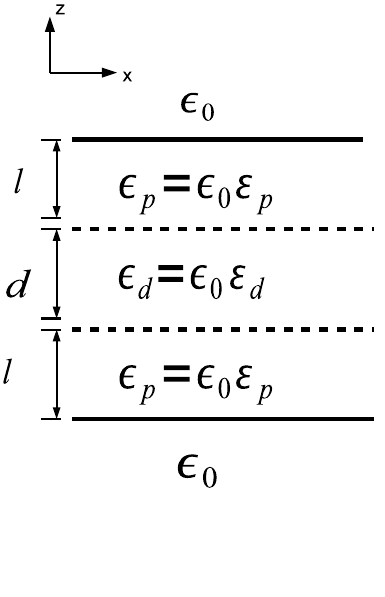
Figure 1: Geometry of the